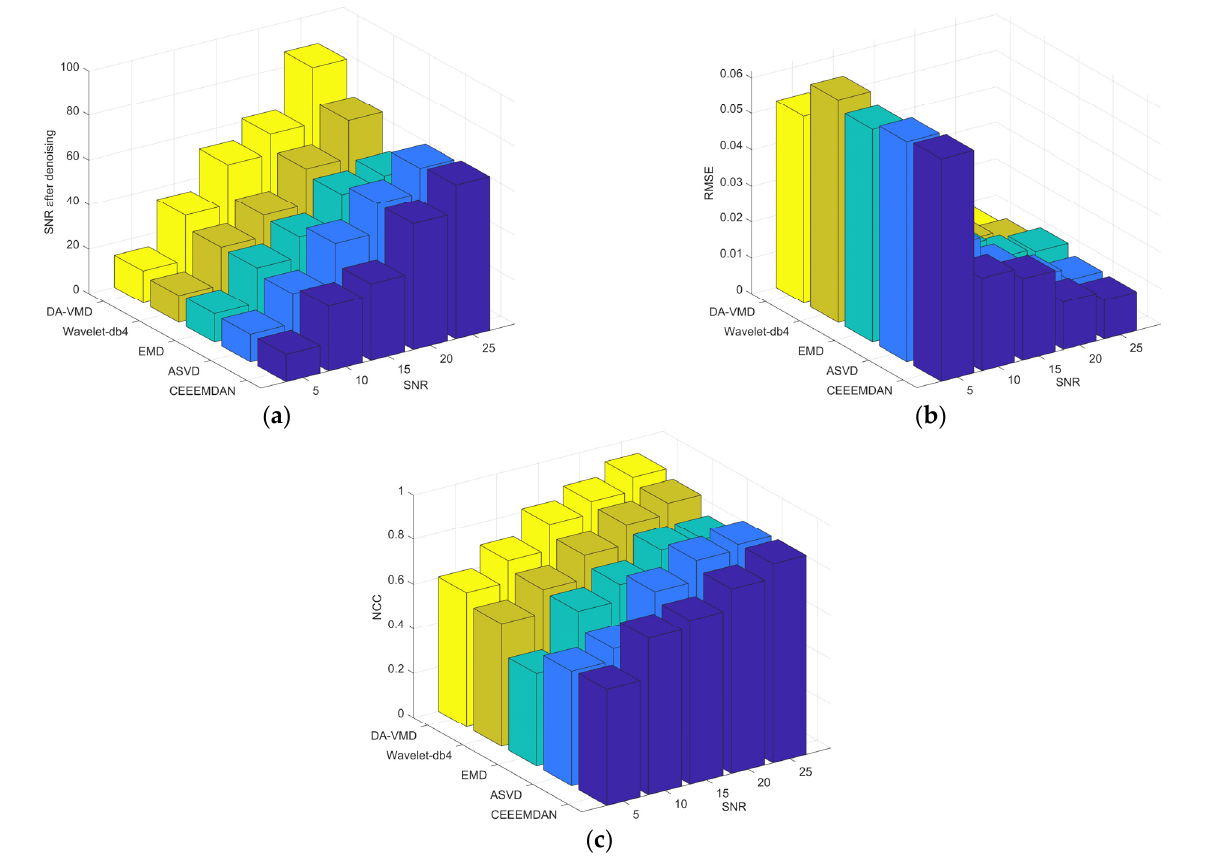
Figure 19. Denoising signal of different denoising methods with SNR = 10 (8–11.7 µm). ( a ) SNR; ( b ) RMSE; ( c ) NCC. ( b ) RMSE; ( c )